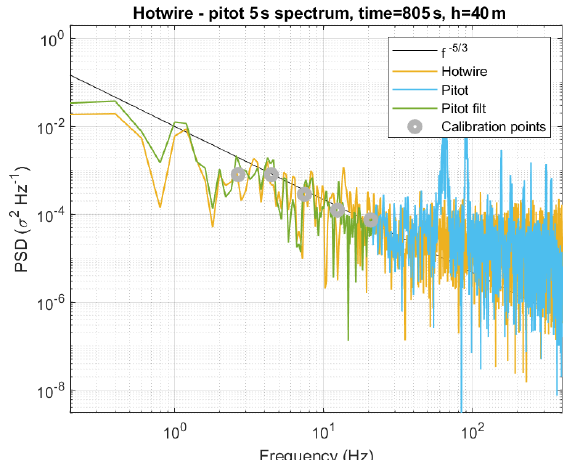
Figure 2. Comparison of hot-wire and pitot spectra for one 5s seg- ment on 13 July 2020. The hot-wire fluctuations are calibrated to the pitot fluctuations in the frequency range marked by the gray dots (“pitot